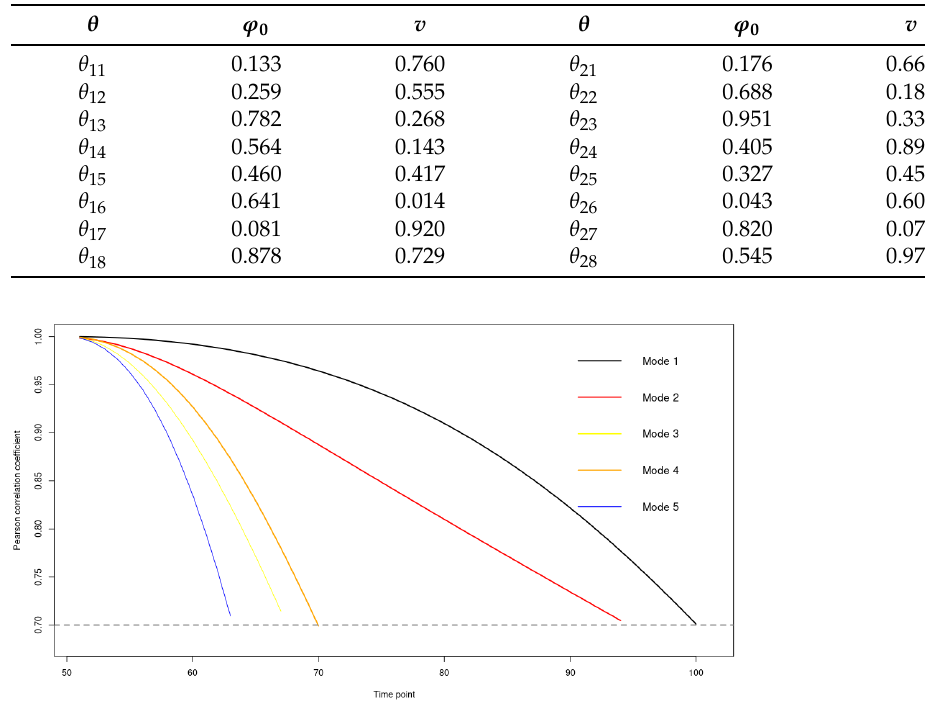
Figure 2. Time correlations of the time-varying coefficient corresponding to the first five POD modes in the advection equation